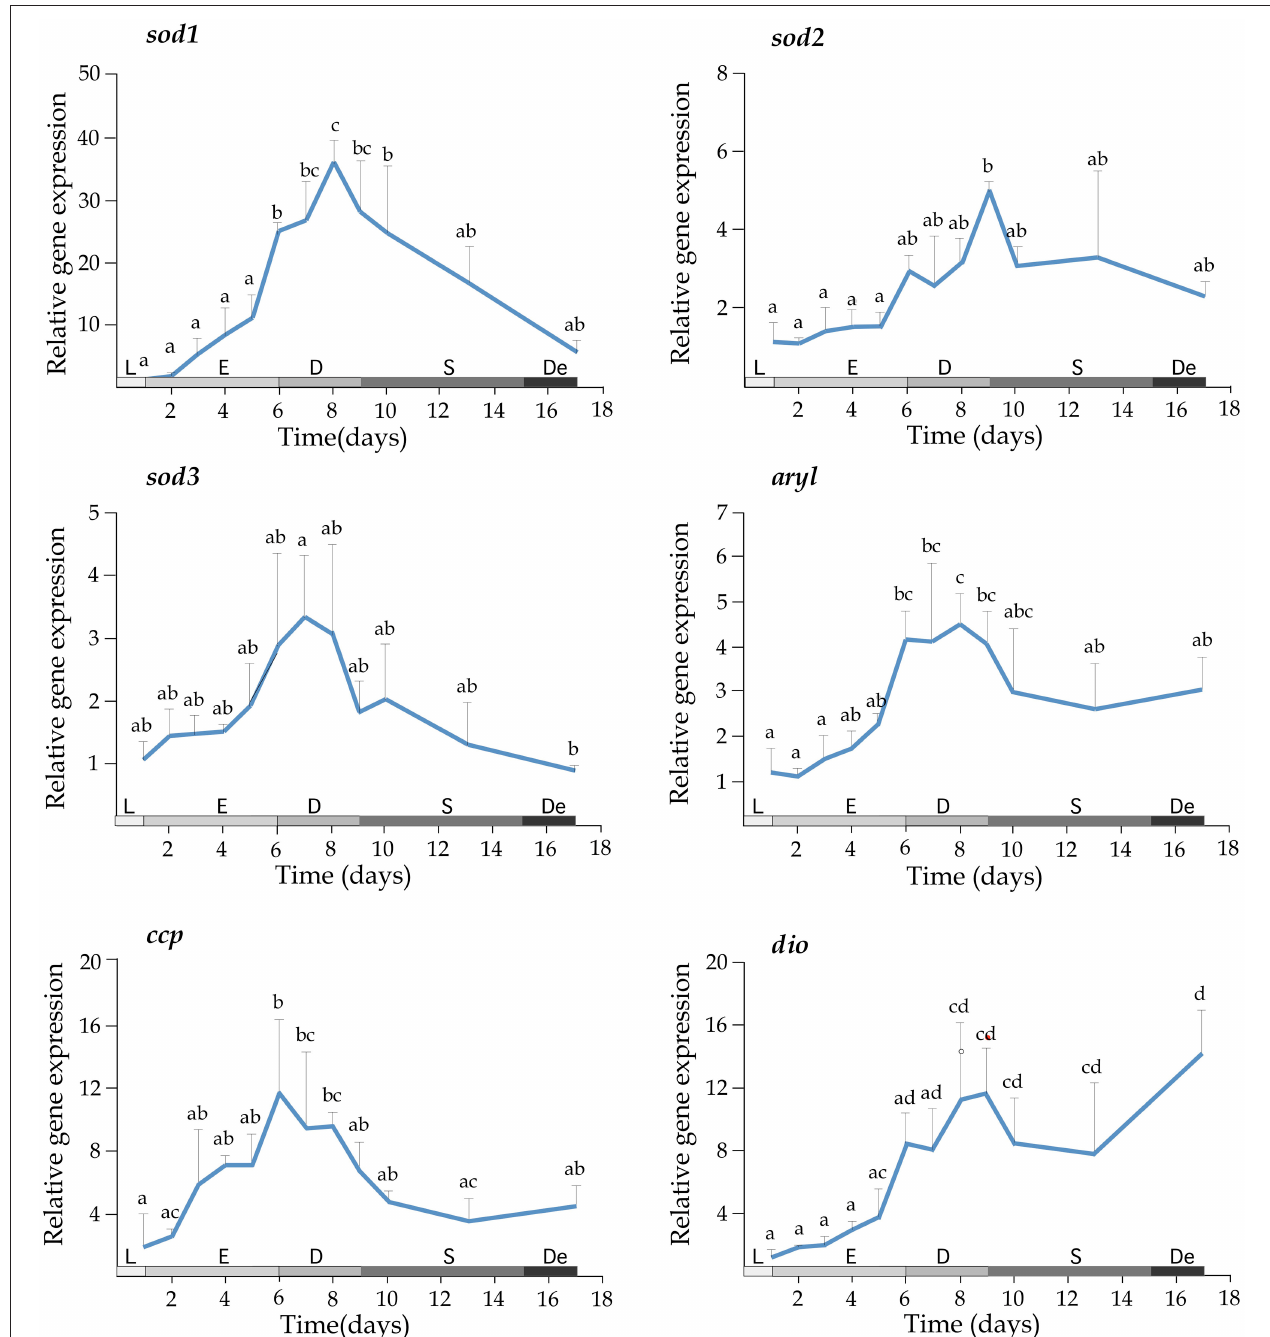
FIGURE 4 | Expression profiles of sod1 , sod2 , sod3 , aryl , ccp, and dio during the growth of T. lutea . Data represent the mean ± SEM. Data were normalized using ubi and calibrated to 1 day of culture. Different letters denote statistically significant differences between sampling times after the post-hoc test. The growth stages including lag phase (L), exponential phase (E), declining of growth phase (D), stationary phase (S), and death phase (De) are shown below.